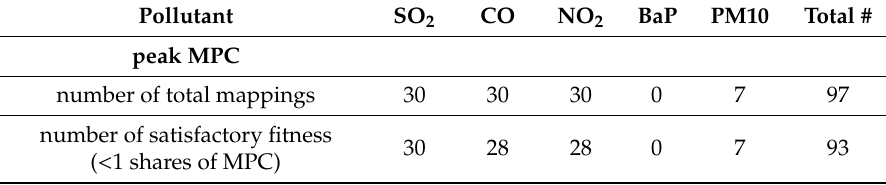
Table 11. The numbers of matches of simulated and measured values pollutants